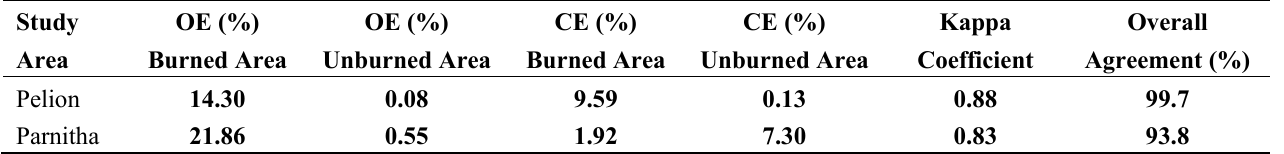
Table 4. Omission (OE) and Commission (CE) errors for burned and unburned areas, kappa coefficients and overall agreement for the study areas of Pelion and Parnitha.